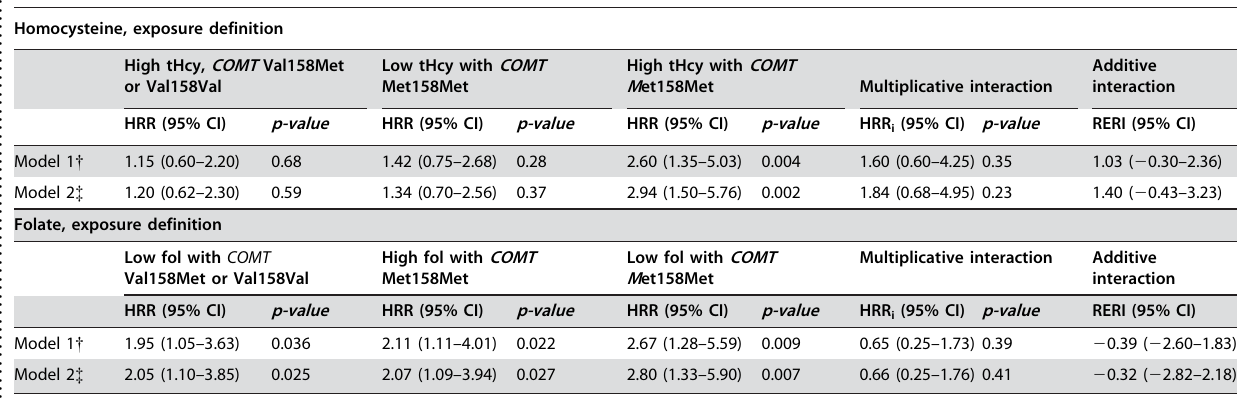
Table 3. Adjusted HRR and 95% CI of Incident Acute Coronary Events Associated with the COMT Genotype*, Plasma tHcy and Serum Folate and Gene-Homocysteine and Gene-Folate Interactions .. ... .... ... ... .... ... ... .... ... ... .... ... ... .... ... ... .... ... ... .... ... ... .... ... ... .... ... ... .... ... ... .... ... ... .... ... ... .... ... ... .... ... ...